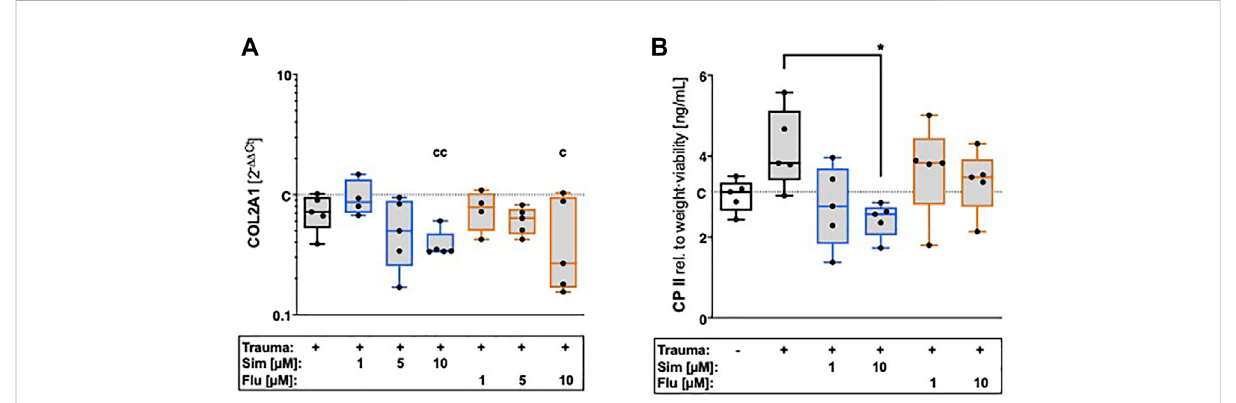
FIGURE 4 Effects of statin treatment on collagen type II expression after cartilage trauma. Expression of COL2 was determined by means of (A) gene expression analysis of COL2A1 as well as (B) quanti fi cationof CPII release.Signi fi cant differences between groups were depicted as [versus T] *= p